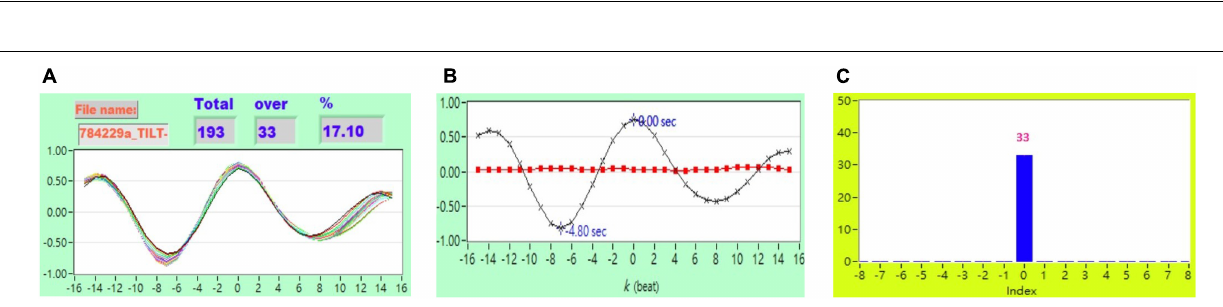
FIGURE 6 | (A) Representative plot of CCF curves with thresholding [–5 (cid:53) k (cid:53) 5 and CCF(k) > 0.7] (B) mean CCF value ( x ) and SD ( (cid:4) ), and (C) distribution bar chart of maximum CCF index during tilt in a healthy subject.